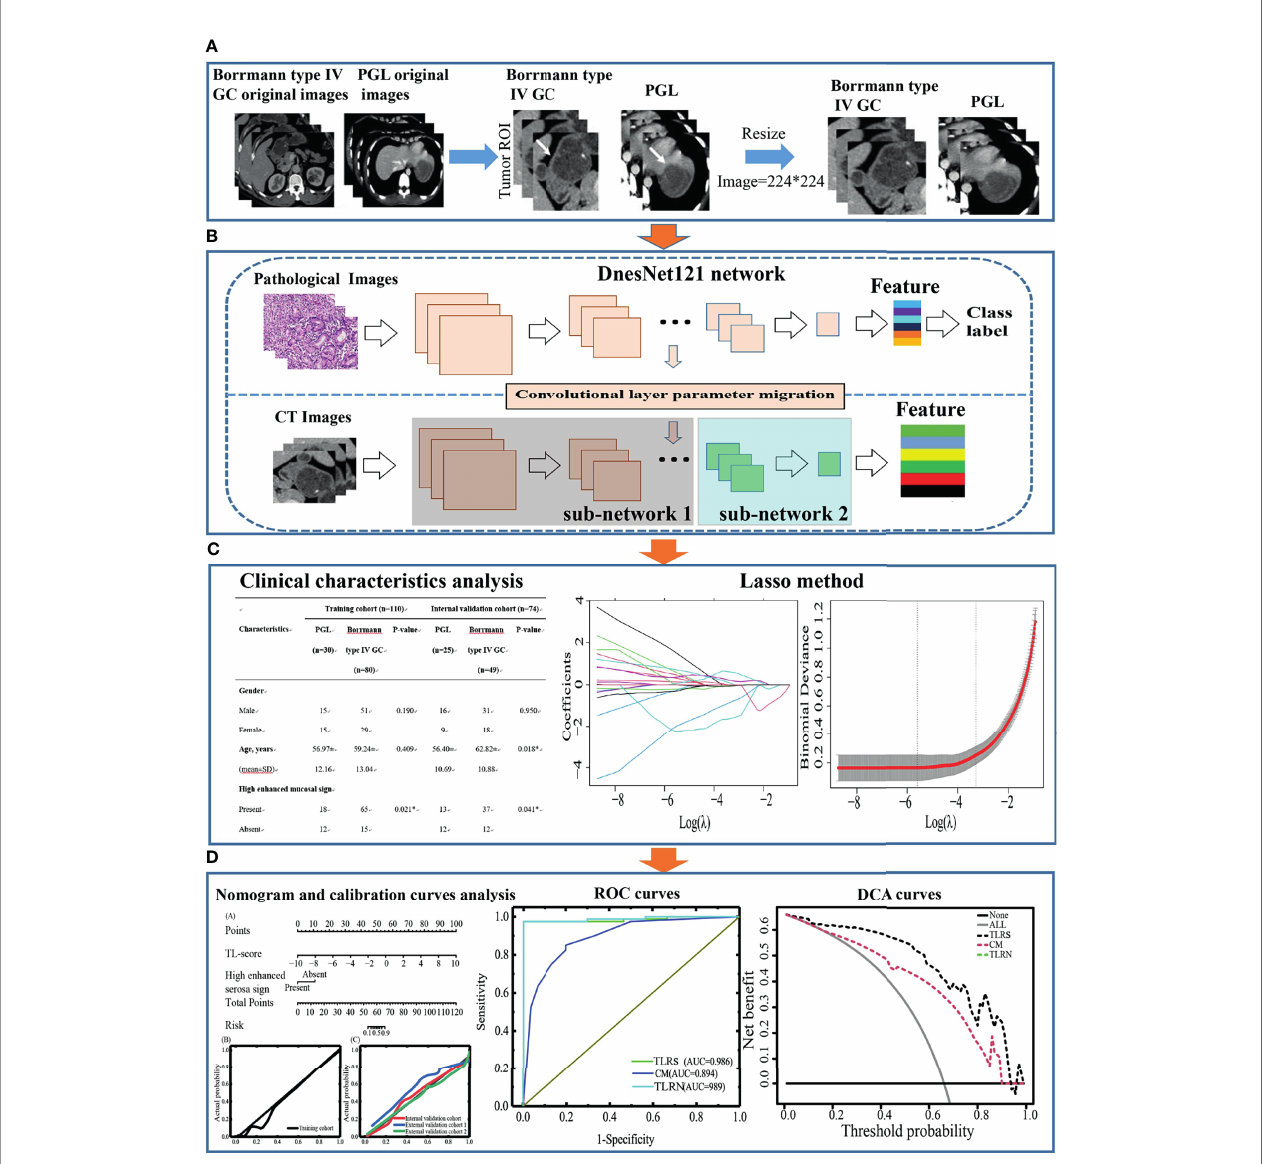
FIGURE 1 | The design fl ow chart of this paper. (A) Acquisition of ROI images for Borrmann type IV GC and PGL. (B) The ROI features extraction by Densenet121. (C) Transfer learning features selection process and model building, statistical analysis of clinical characteristics, and CT subjective fi ndings. (D) Performance evaluation of the transfer learning radiomics nomogram. GC, gastric cancer; PGL, primary gastric lymphoma; ROI, region of